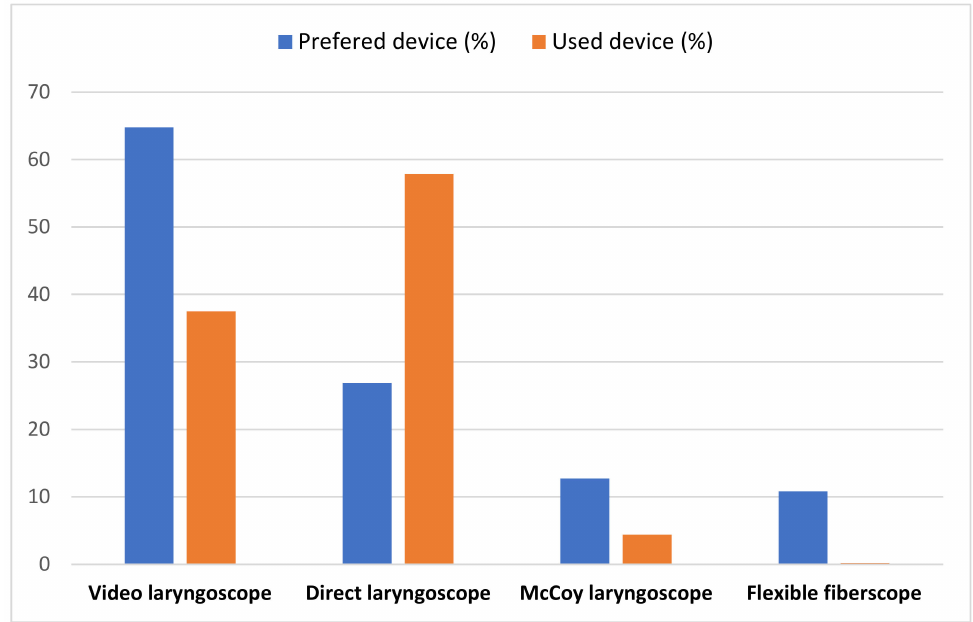
Figure 5. Percentage of the most preferred or used airway devices to intubate COVID-19 patients. Among the preferred devices for tracheal intubation in cases of predicted or known difficult airway in patients with COVID-19, the video laryngoscope was chosen (61.7%), followed by the fiberscope (31.6%) (Table 3). The respondents’ preferred tracheostomy technique was percutaneous versus open tracheostomy (Table S1). Intubation while wear- ing PPE was very uncomfortable for the staff who performed it; moreover, intubation was associated with increased difficulty in performing the technique (Table S1).